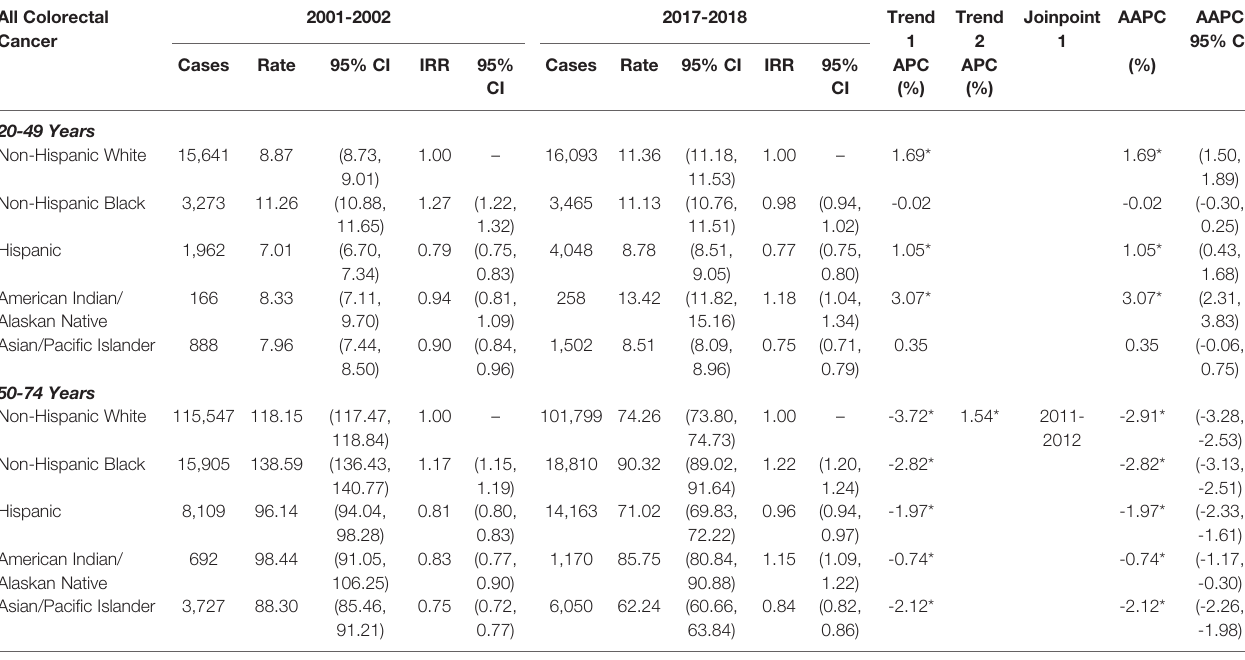
TABLE 3 | Age ‐ adjusted early ‐ onset (20-49 years of age) and late ‐ onset (50-74 years of age) colorectal adenocarcinoma rates per 100,000 person ‐ years. All Colorectal Cancer